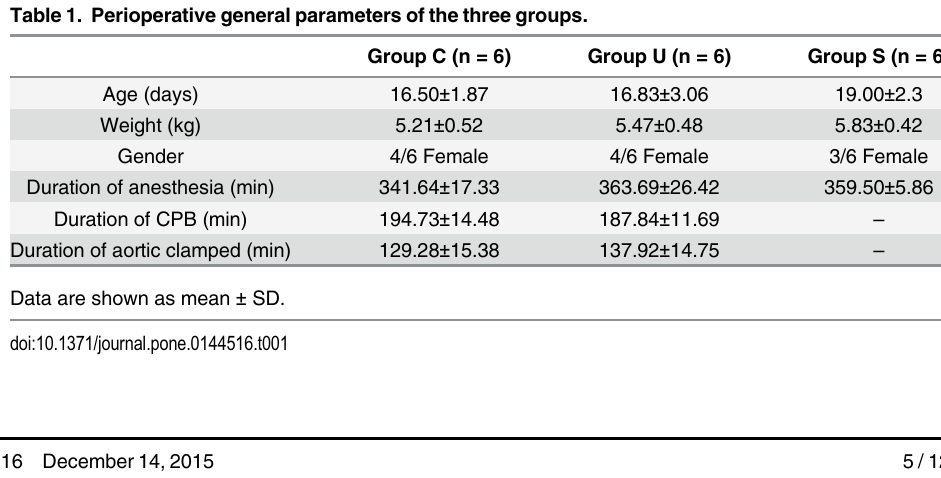
Table 1. Perioperative general parameters of the three groups.